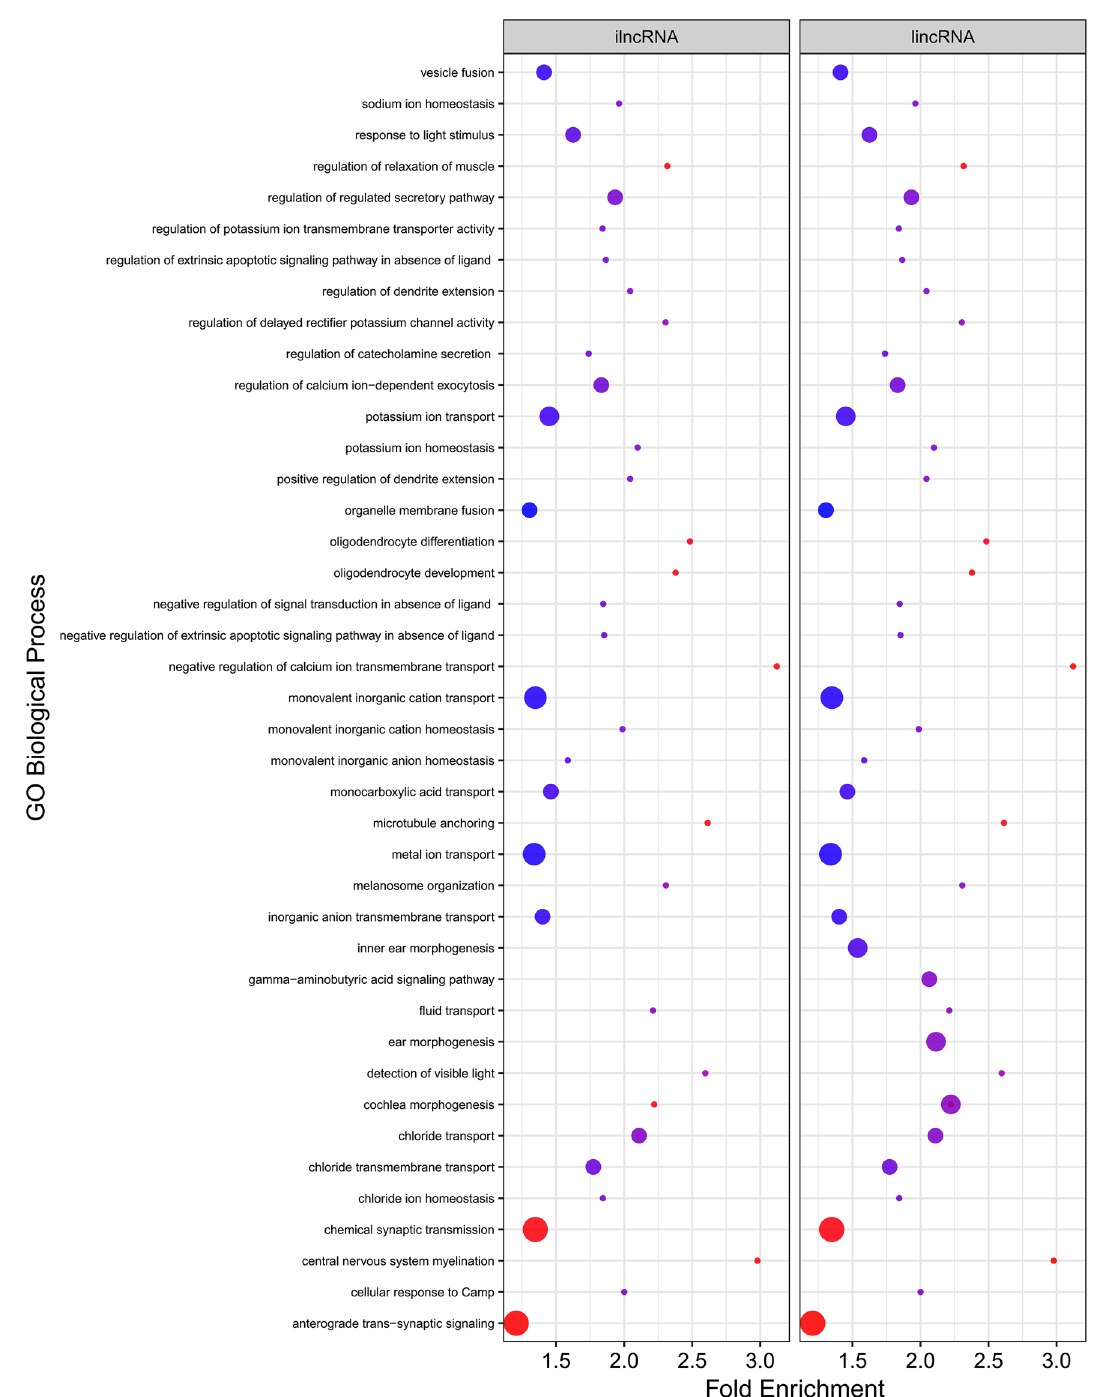
Figure 5. Functional enrichment analysis of the trans target genes of predicted known lincRNAs and